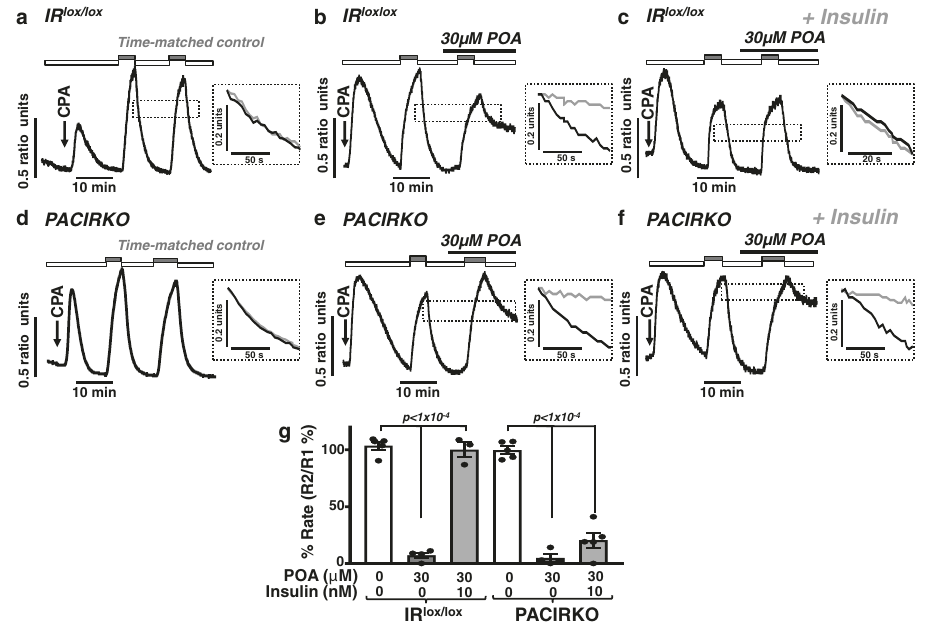
Fig. 6 Insulin-mediated protection against palmitoleic acid-induced inhibition of the PMCA is abolished in pancreatic acinar cells from PACIRKO mice. Representative traces showing time-matched control in situ [Ca 2 + ] i clearance experiments ( a , d ) and the effect of POA ( b, e ) on [Ca 2 + ] i clearance in untreated cells ( b , e ) and cells pre-treated with 10 nM insulin ( c , f ) in pancreatic acinar cells from IR lox/lox ( a – c ) and PACIRKO mice ( d – f ). Cells were treated with 30 μ M CPA (arrow) in the absence of external Ca 2 + (1 mM EGTA; white bar) or 20 mM Ca 2 + (grey bar) to induce store-operated Ca 2 + in fl ux phases. POA was added prior to the re-addition of 20 mM external Ca 2 + .during the second in fl ux-clearance phase (black bar). Inset dashed box ( a – f ) shows superimposed expanded time-courses of fi rst (black trace) and second clearance phase (grey trace). Traces are representative of 5 (IR lox/lox time- matched control, a ), 4 (IR lox/lox POA, b ), 3 (IR lox/lox POA with insulin, c ), 5 (PACIRKO time-matched control, d ). 4 (PACIRKO POA, e ) and 5 (PACIRKO POA with insulin, f ) separate experiments. Linear clearance rate (in the presence of POA) was normalized to the initial clearance rate in each cell (% relative clearance rate). g Mean % relative clearance (±SEM) of corresponding time-matched control (white bar), POA treatment (30 μ M; dark grey bar), and POA with insulin (light grey bar). Signi fi cance (specifc p values as indicated) was determined by one-way ANOVA with Sidak ’ s multiple comparisons. Data were derived from individual values from multiple cells (3-19 cells per experiment) in the fi eld of view for each experiment. These values were averaged giving the experimental mean, that were in turn averaged across multiple experiments giving the true mean ± SEM as indicated in ( g mice (Fig. S9a, b). In addition, immunoprecipitation of IRS-1 or IRS-2 followed by subsequent western blotting with the pan- phosphotyrosine antibody, revealed that IRS1 (Fig. S9c), and to a lesser extent IRS-2 (Fig. S9d), were hyperphosphorylated.